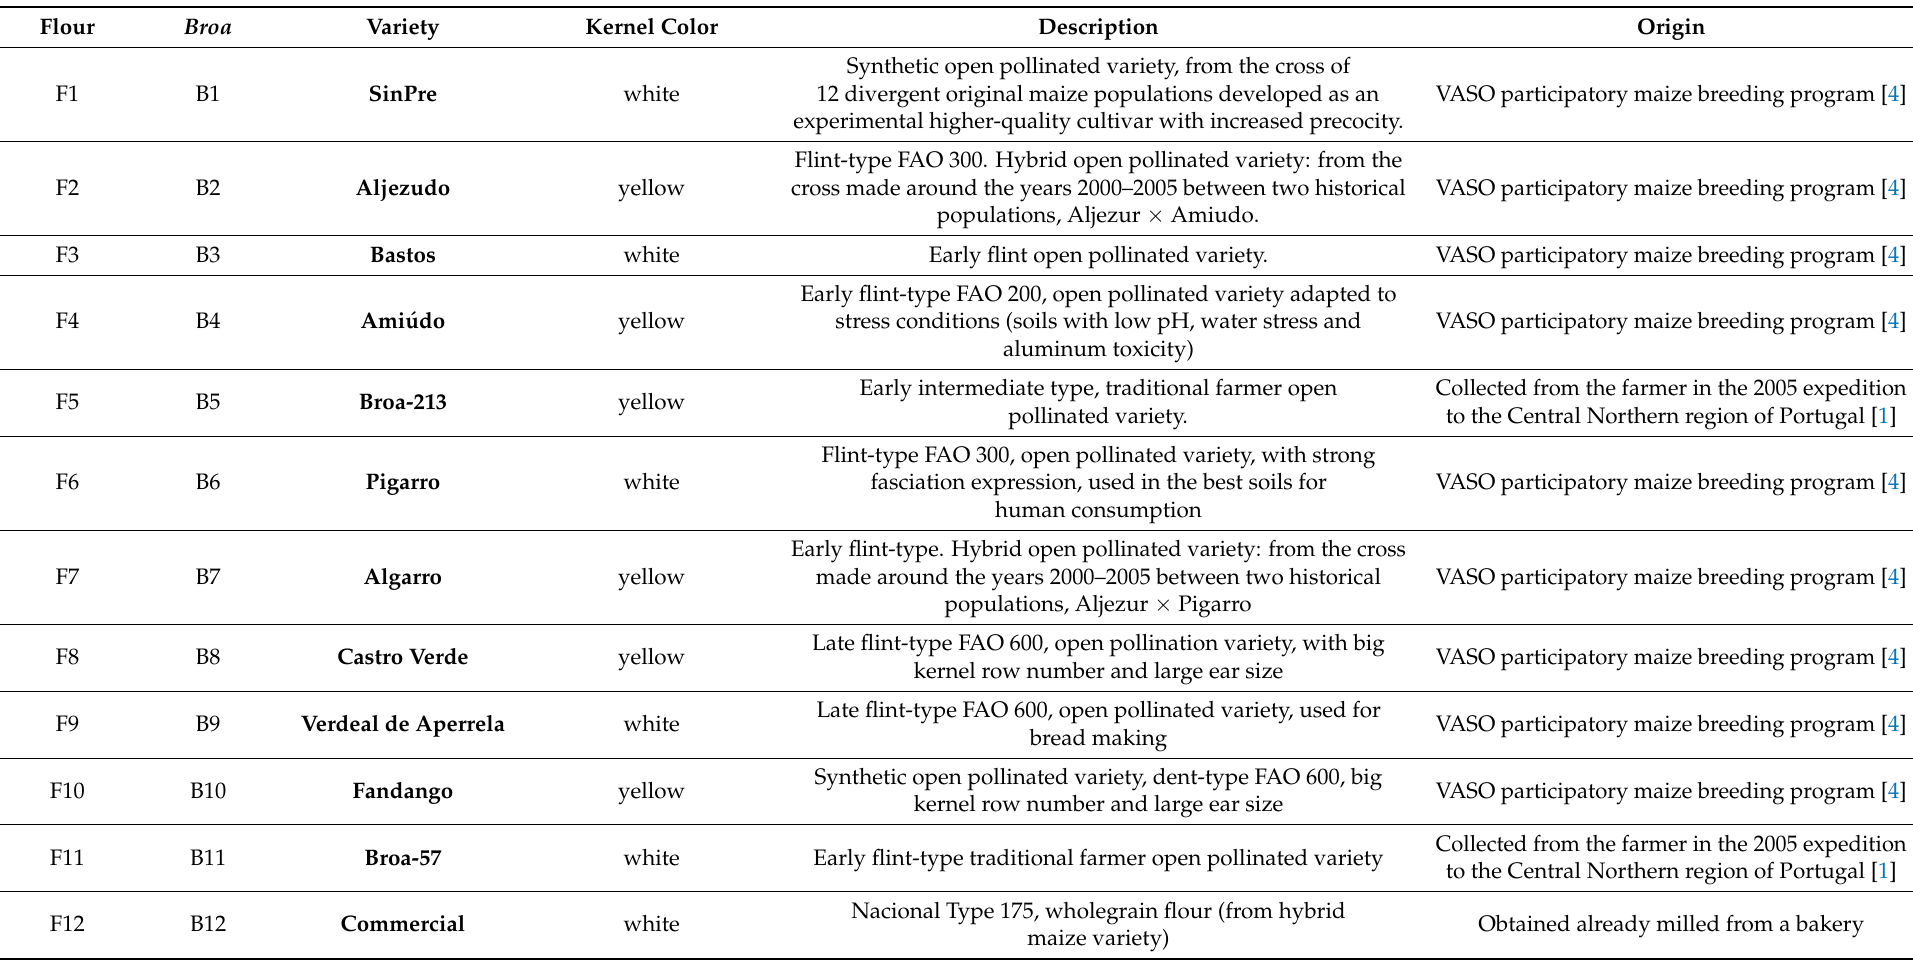
Table 1. Maize flours and broas identification and